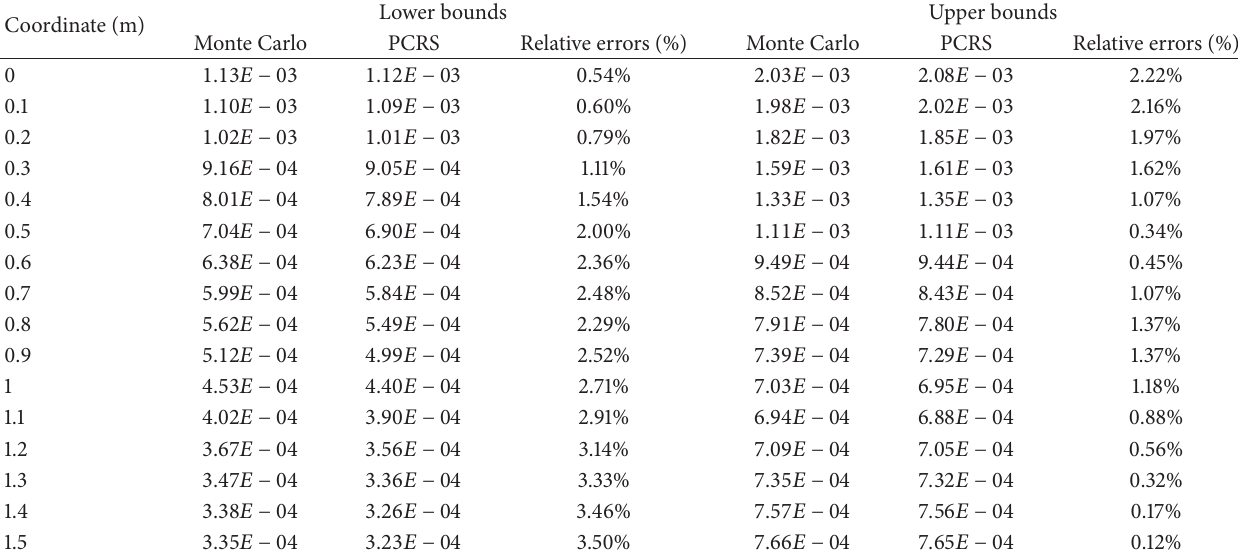
Table 4: The relative errors of the lower and upper bounds of variance of the frequency response amplitude along the line of 𝑦 = 0.5 m. Coordinate